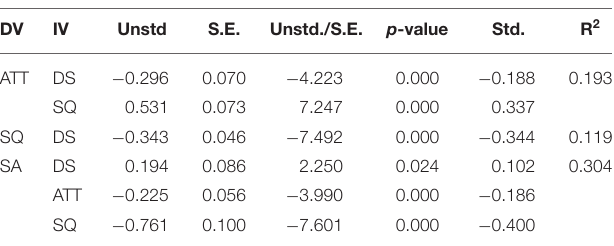
TABLE 7 | Regression